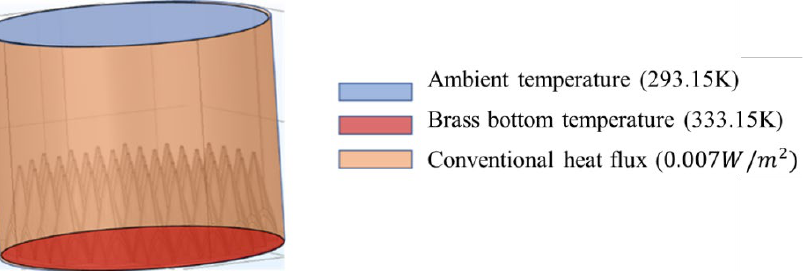
Figure 9. Temperature-distribution model of the coated cone array.